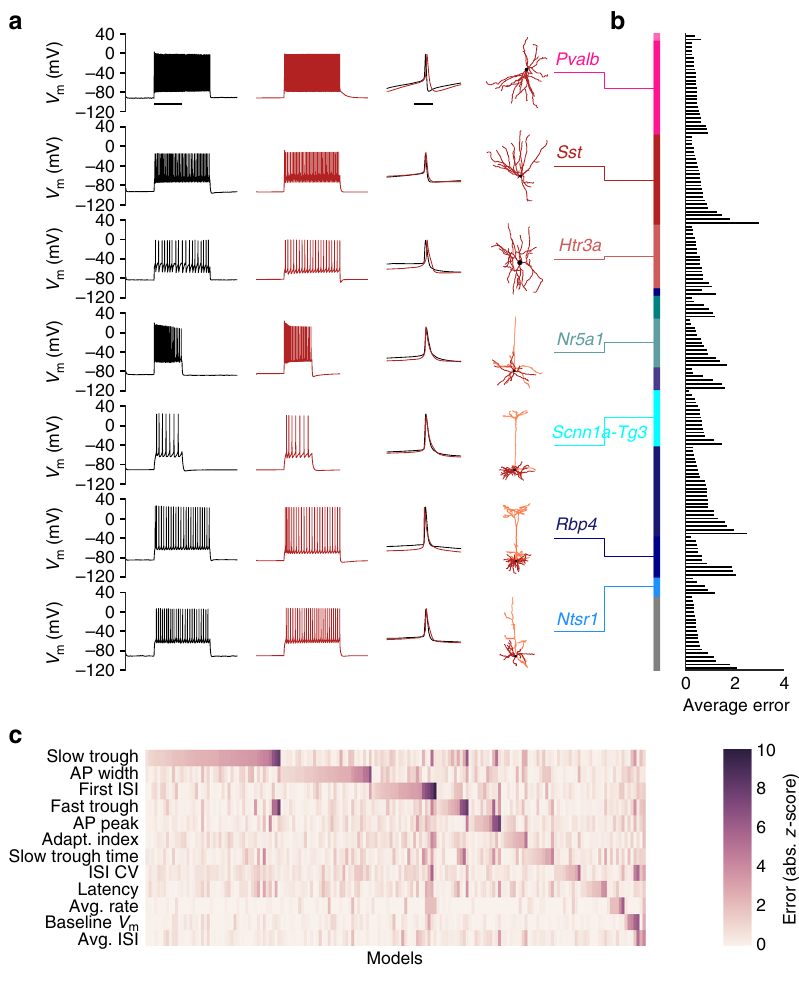
Fig. 5 Example models and summary of training errors. a Voltage traces showing the experimental responses (black, scale bar: 1 s) and model responses (red), including a comparison of individual action potentials (scale bar: 5 ms), for seven neurons from a variety of transgenic lines. The dendritic morphologies for each cell are also shown. b Average training errors for all 170 models. Models are organized by transgenic line (color bar; groups shown from top to bottom are Gad2 , Pvalb , Sst , Htr3a , Slc17a1 , Cux2 , Nr5a1 , Scnn1a-Tg2 , Scnn1a-Tg3 , Rorb , Rbp4 , Ntsr1 , and unlabeled) and then in ascending order of average training error. c Training errors for speci fi c features for each of 170 models. Errors are reported as absolute z -scores. Models are sorted by the feature that had the highest remaining